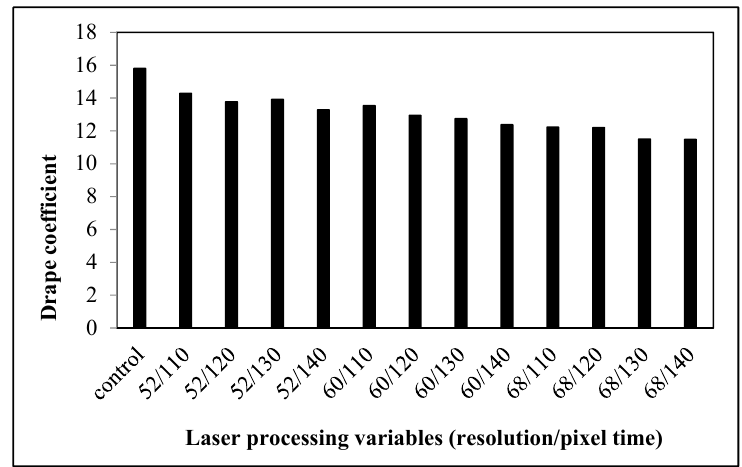
Figure 6. Relationship between laser processing variables and the drape coefficient of cotton fabric.